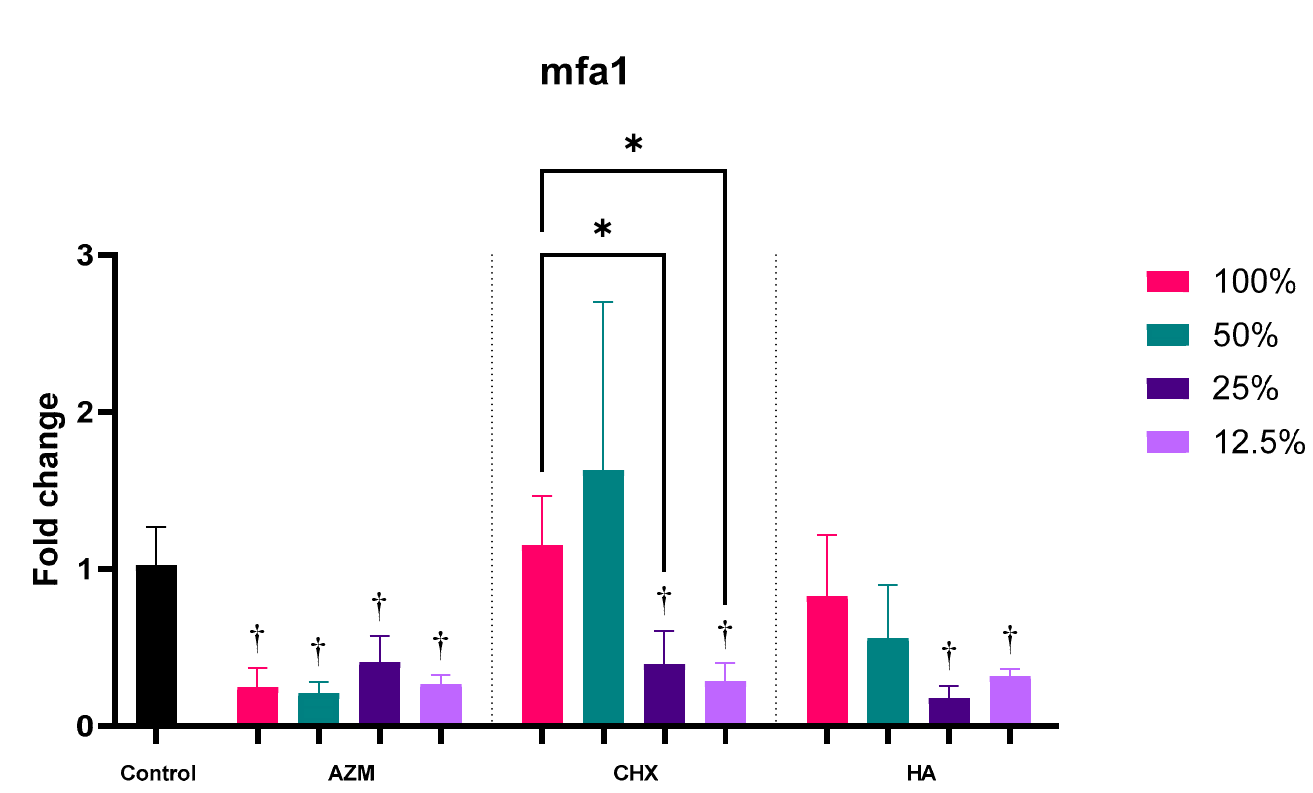
Figure 5. Fold-change values (mean ± SD) of different concentrations on expression of mfa1. >0.05 (ns), ≤ 0.05 (*), ≤ 0.01 (**), ≤ 0.001 (***), ≤ 0.0001 (****). Statistically significant compared to control p < 0.05 (†).